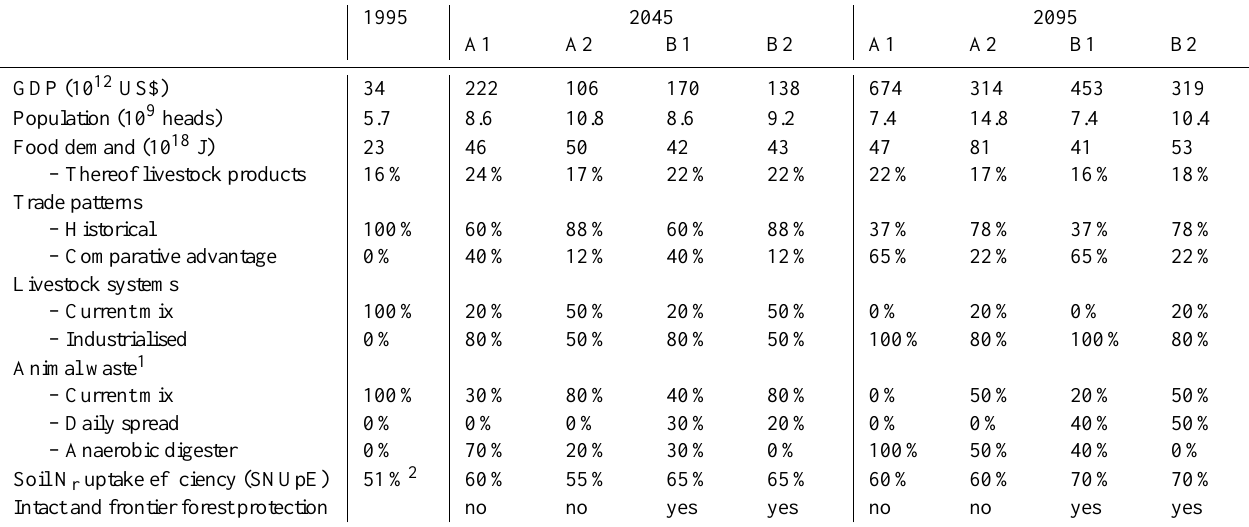
Table 1. Scenario definitions, based on the IPCC SRES